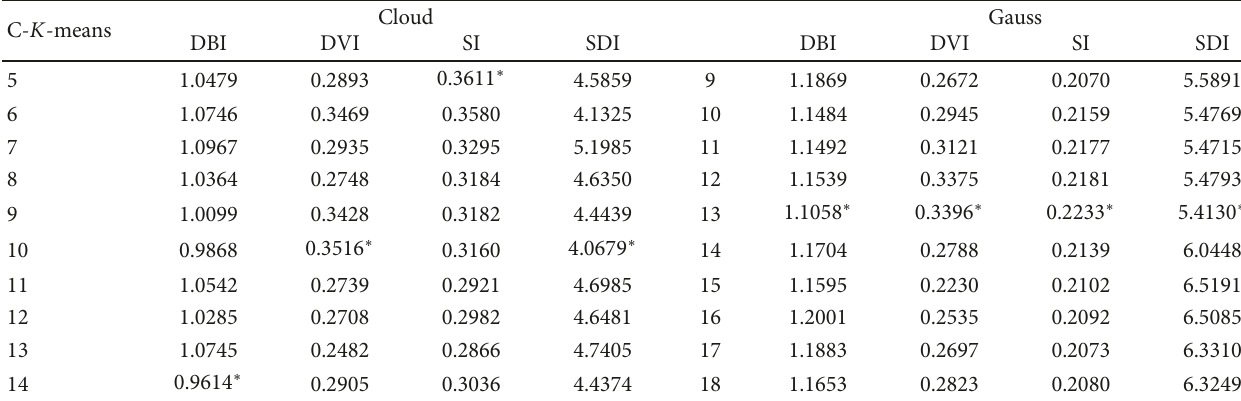
Table 4: The value of k is unknown (Cloud and Gauss; ∗ denotes the optimal